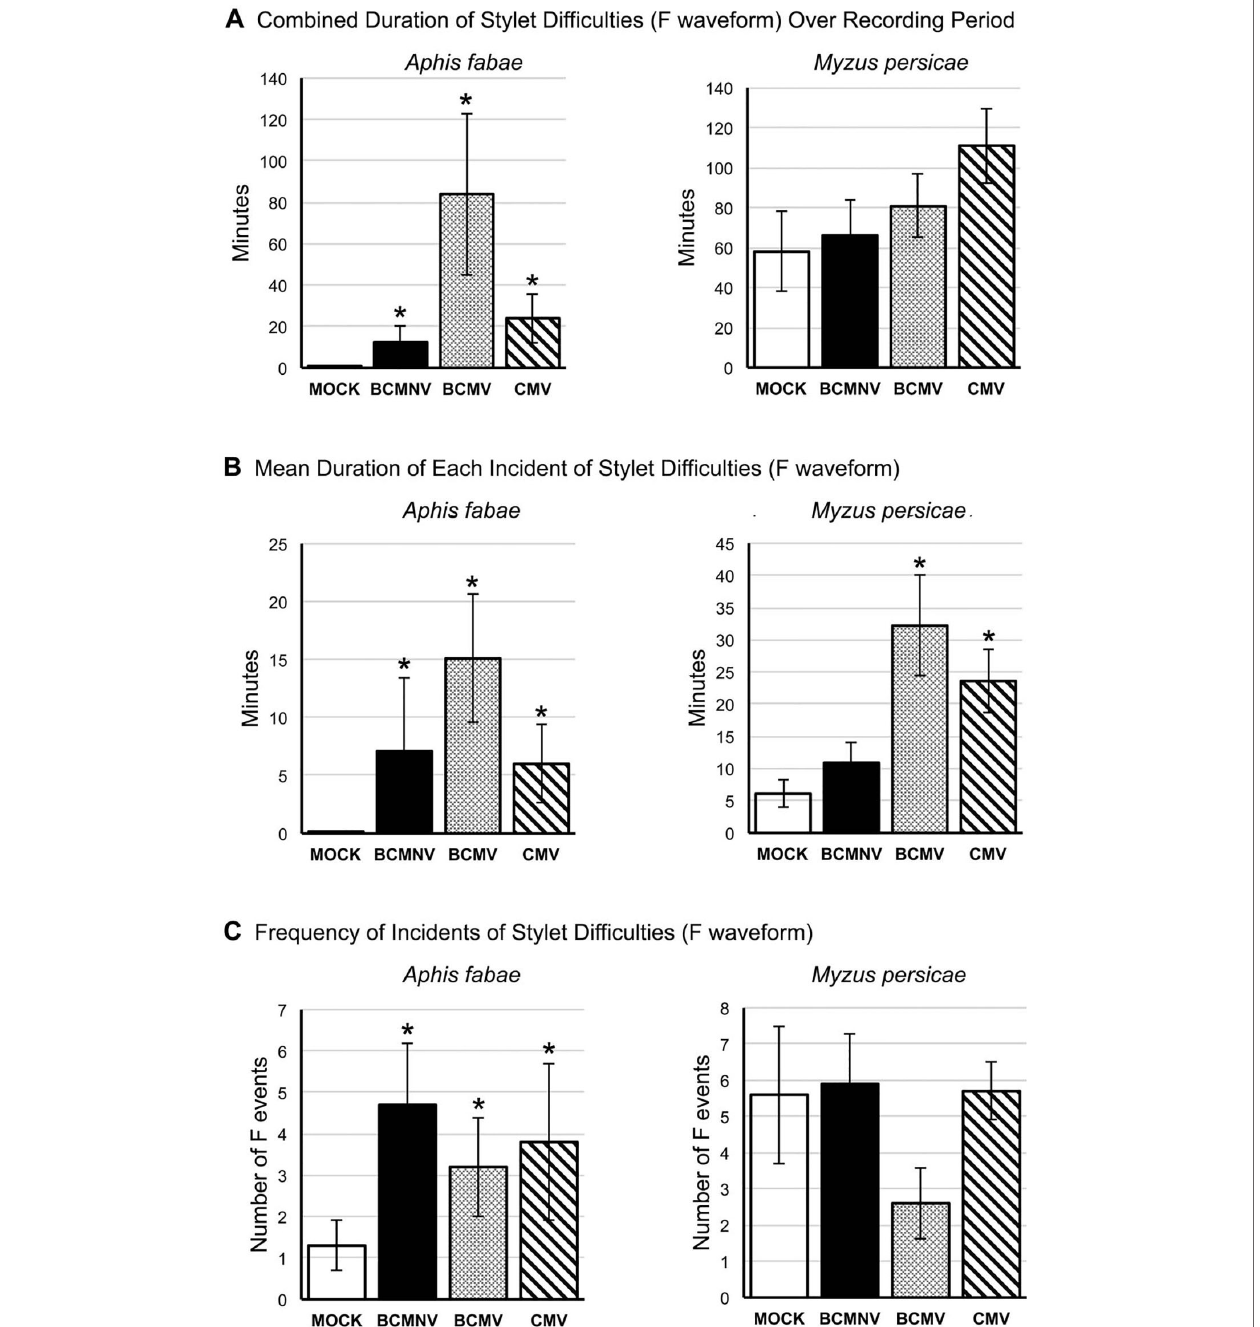
FIGURE 6 | Mechanical stylet dif fi culty during aphid feeding is more frequently encountered by aphids placed on virus-infected plants. EPG data was analyzed to reveal: (A) the overall duration of time over the recording period in which aphids (the legume specialist, Aphis fabae , or the generalist, Myzus persicae ) encountered stylet mechanical feeding dif fi culties (Waveform F: Table 1 ); (B) the mean duration of instances offeeding dif fi culty; and (C) the frequency of these feeding dif fi culty incidents over the recording period on mock-inoculated plants or plants infected with BCMNV, BCMV, or CMV. In contrast to their feeding on mock-inoculated plants A. fabae encountered more feeding dif fi culties on virus-infected plants ( A , left panel) that were, in addition, more protracted (B) and more frequent (C) . The non-specialist aphid M. persicae experienced feeding dif fi culties even on mock-inoculated common bean plants and there was no overall increase in time spent experiencing feeding dif fi culties or in the frequency of these events on virus-infected plants as was the case for A. fabae (A, C) . However, M. persicae experienced more prolonged incidents offeeding dif fi culty on plants infected with BCMV and CMV ( B , right panel). Asterisks denote signi fi cant differences in stylet dif fi culty between insects on virus-infected and mock-inoculated plants (Dunnett test, p < 0.05: see Supplementary Table 1 for analyses). Error bars represent the standard error of the